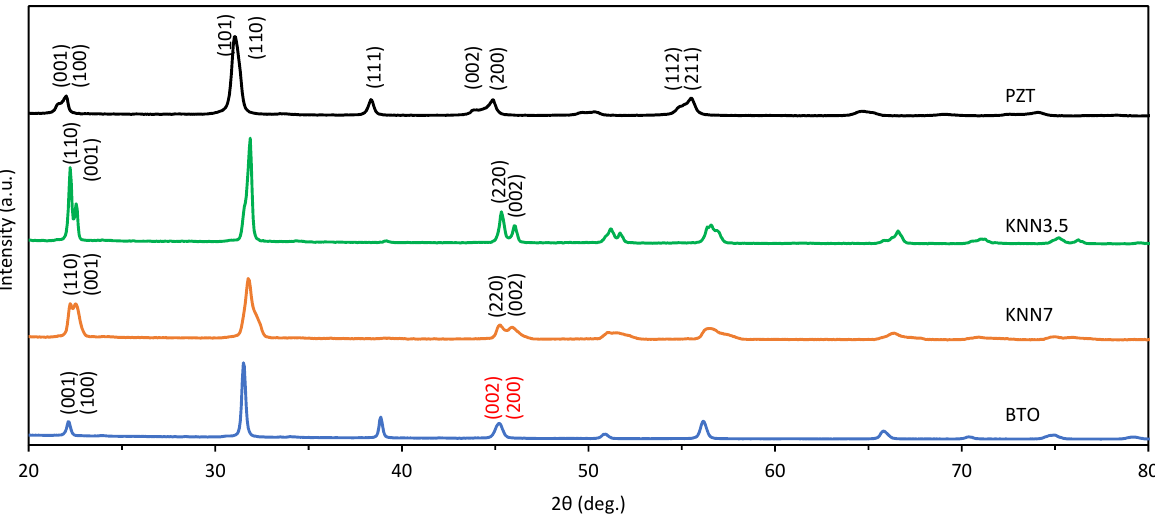
Figure 2. XRD patterns of ceramic powders (as received) used in this study at room temperature.